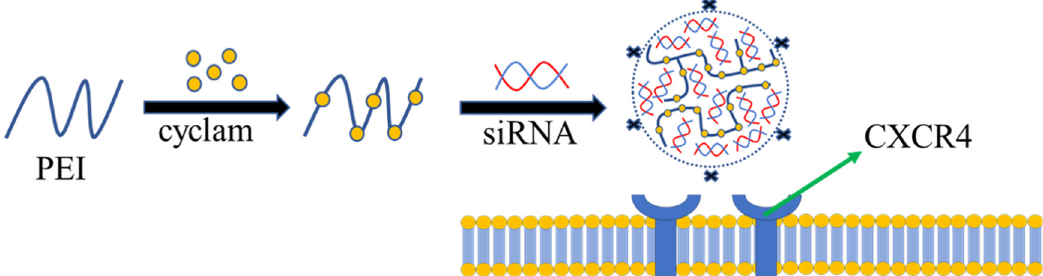
Figure 2. Cyclam modified PEI is used for the delivery of